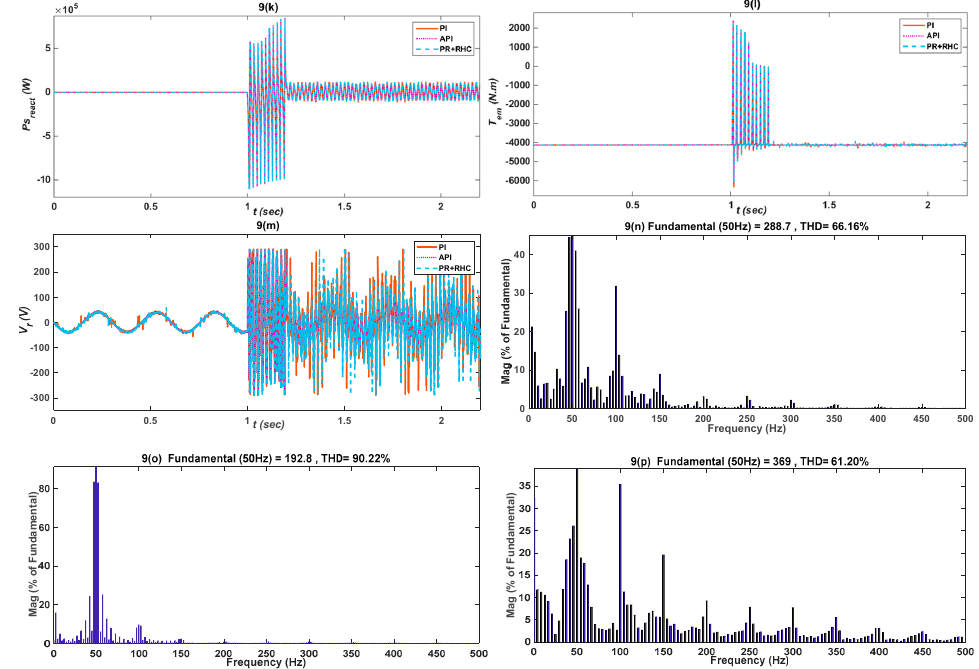
Figure 9. Comparison of PI and Proposed API and PR+RHC controller responses under undervoltage fault considering: ( a ) Dc-link voltage V dc ; ( b ) Stator voltage V s ; ( c – e ) Active component of current I d ;